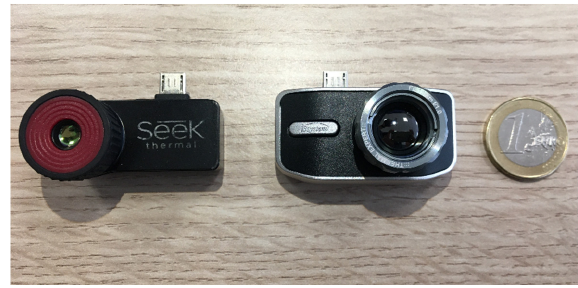
Figure 1. Selected thermal cameras: ST (left) and TE-Q1 (right).